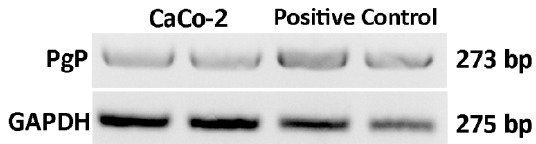
Figure 5. Representative analysis of P-gp expression in Caco-2 cells. PCR products were separated on 1.8% agarose gel containing Safeview. Table 7. Apparent permeability coefficients (P app ) of free-SLM and SLM-loaded nanomicelles. (Mean ± SD, n = 3).